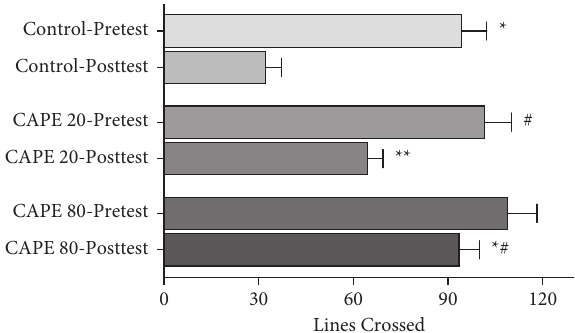
Figure 3: The numbers show the activity level as the total number of squares crossed during a 5 min testing period. Intrastriatal CAPE treatment (20 and 80 μ mol/5 μ L) reversed the decreases in loco- motor activity observed in the 6-OHDA-lesioned group, and this protective effect was higher in the CAPE 80 group. Control group, n � 7; CAPE 20 group, n � 9; CAPE 80 group, n � 8 ( ∗ p < 0 . 01 versus control posttest, ∗∗ p < 0 . 05 versus control posttest; # p < 0 . 05 versus CAPE 20